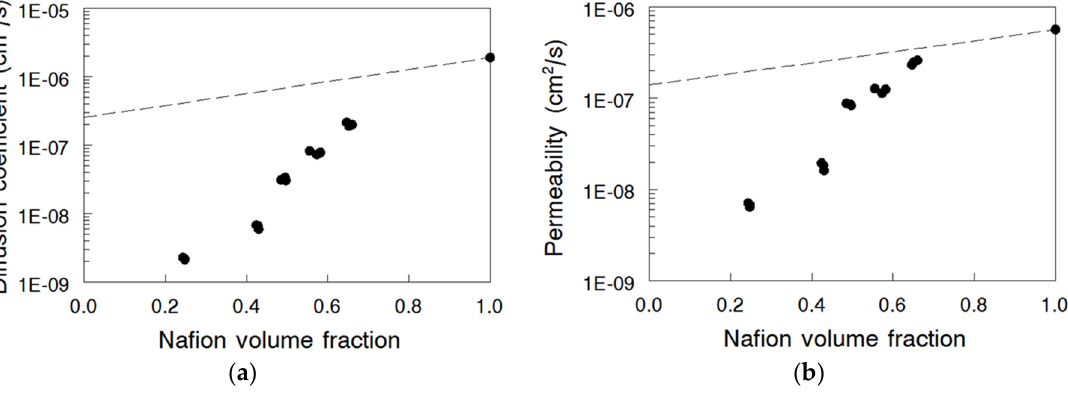
Figure 6. ( a ) Diffusion coefficient of bromine species (Br 2 and Br 3 ‐ ) in Nafion nanofiber composite membranes of different Nafion volume fractions at 25 °C. Diffusion coefficient of Nafion ® 115 was 1.45 ˆ 10 ´ 6 cm 2 /s; ( b ) Steady-state permeability of bromine species (Br 2 and Br 3 ´ ) for the nanofiber 1.45 × 10 − 6 cm 2 /s ; ( b ) Steady ‐ state permeability of bromine species (Br 2 and Br 3 ‐ ) for the nanofiber composite membranes as a function of Nafion volume fractions at 25 ˝ C. Steady-state permeability of composite membranes as a function of Nafion volume fractions at 25 °C. Steady ‐ state permeability of Nafion ® 115 was 4.26 ˆ 10 ´ 6 cm 2 Nafion ® 115 was 4.26 × 10 − 6 cm 2 /s.